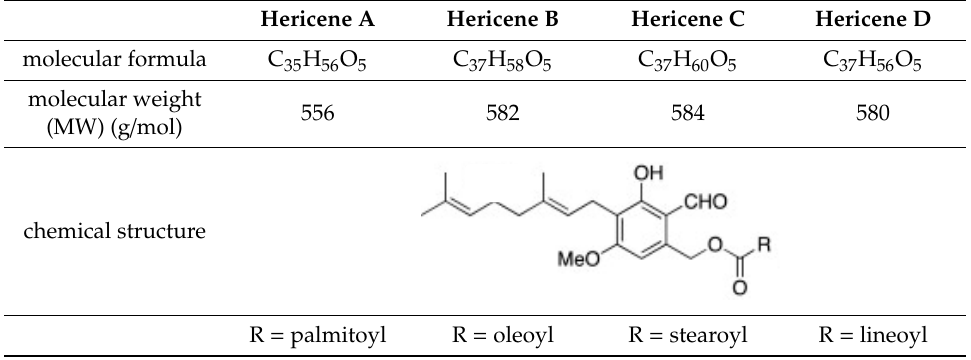
Figure 3. UV traces of mycelium (top) and the standard molecules of hericenones C and D (bottom). Table 3. Molecular formula, chemical structures, and molecular weights of hericenes.